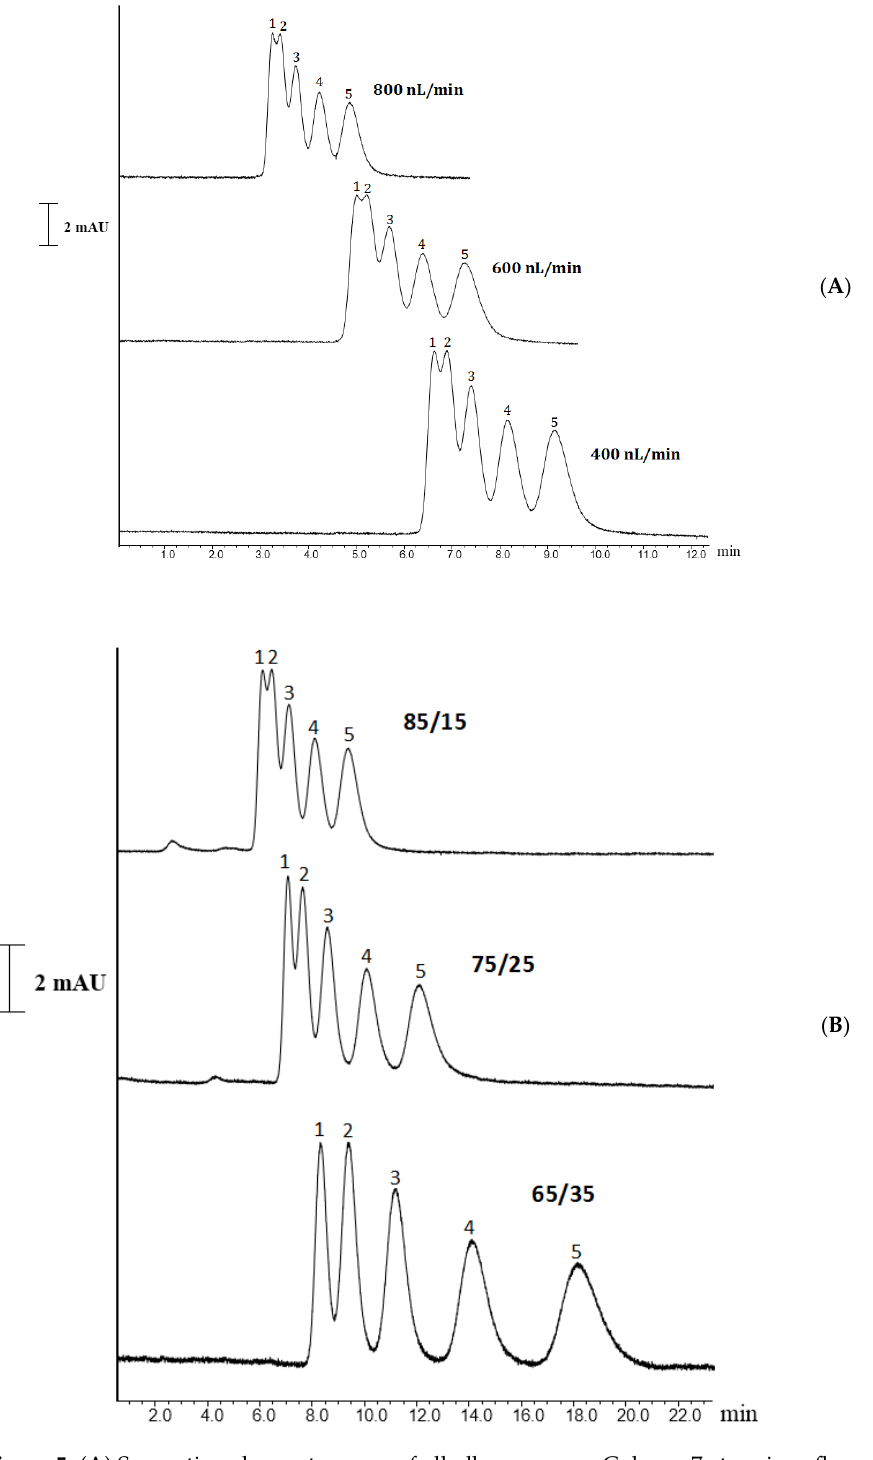
Figure 5. ( A ) Separation chromatograms of alkylbenzenes on Column 7 at various flow rates with 800 nL/min, 600 nL/min and 400 nL. Chromatographic conditions: mobile phase, 80%ACN:20%H 2 O ( v / v ); column dimensions, 13 cm × 50 µ m i.d.; analyte concentration, 0.05 µ g/mL; detection wave- length, 220 nm. Order of peaks: (1) toluene (2) ethylbenzene, (3) propylbenzene, (4) butylbenzene, (5) pentylbenzene. ( B ) Separation chromatograms of alkylbenzenes on Column 7 at various ACN content: 85/15% ( v / v ), 75/25% ( v / v ), and 65/35% ( v / v ). Column dimensions, 13 cm × 50 µ m i.d.; analyte concentration, 0.05 µ g/mL; flow rate, 400 nL/min; detection wavelength, 220 nm. Order of peaks: (1) toluene (2) ethylbenzene, (3) propylbenzene, (4) butylbenzene, (5)